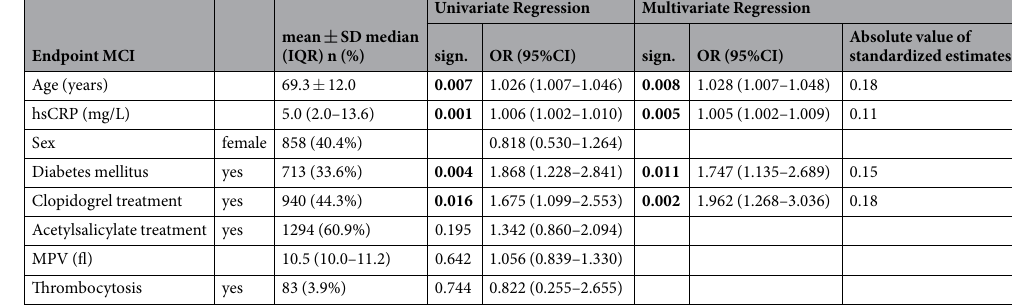
Table 3. Significant predictors for MCI (R² = 0.05). Abbreviations: MPV, mean platelet volume; sign., significance; MCI, myocardial infarction; hsCRP, high sensitive c-reactive protein.